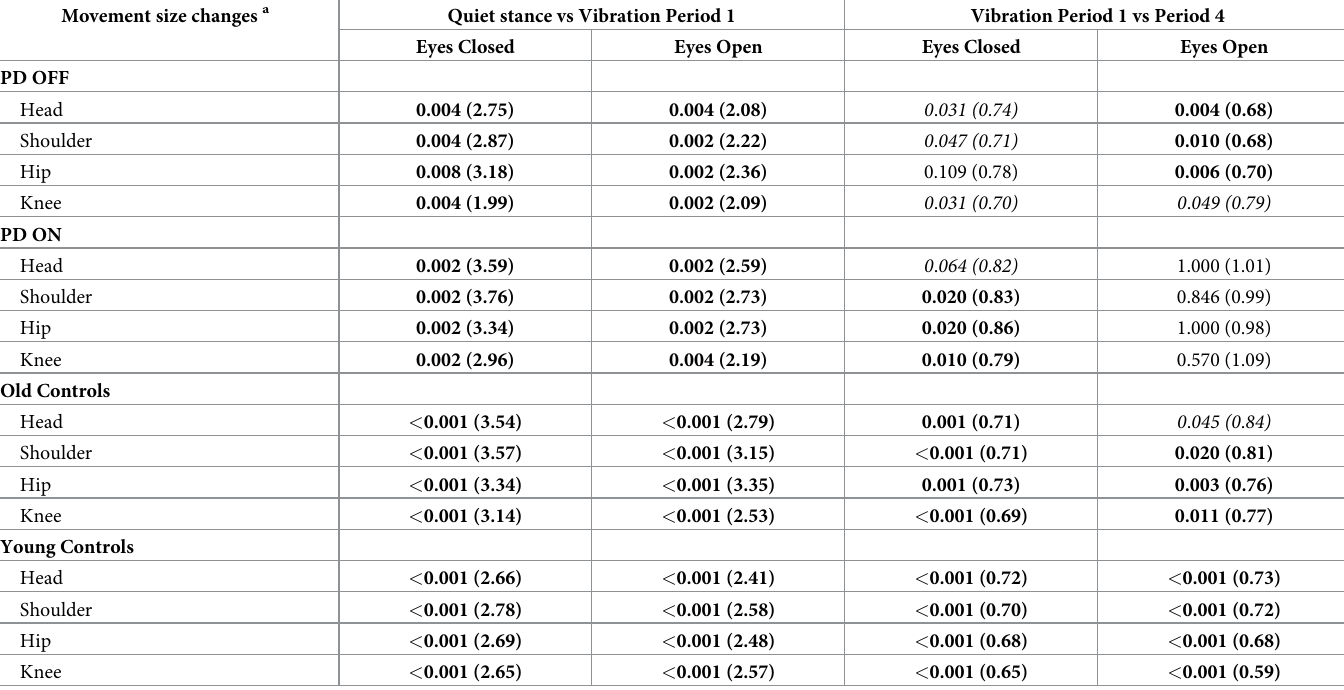
Table 7. Movement size changes between quiet stance and vibration period 1 and between vibration period 1 and period